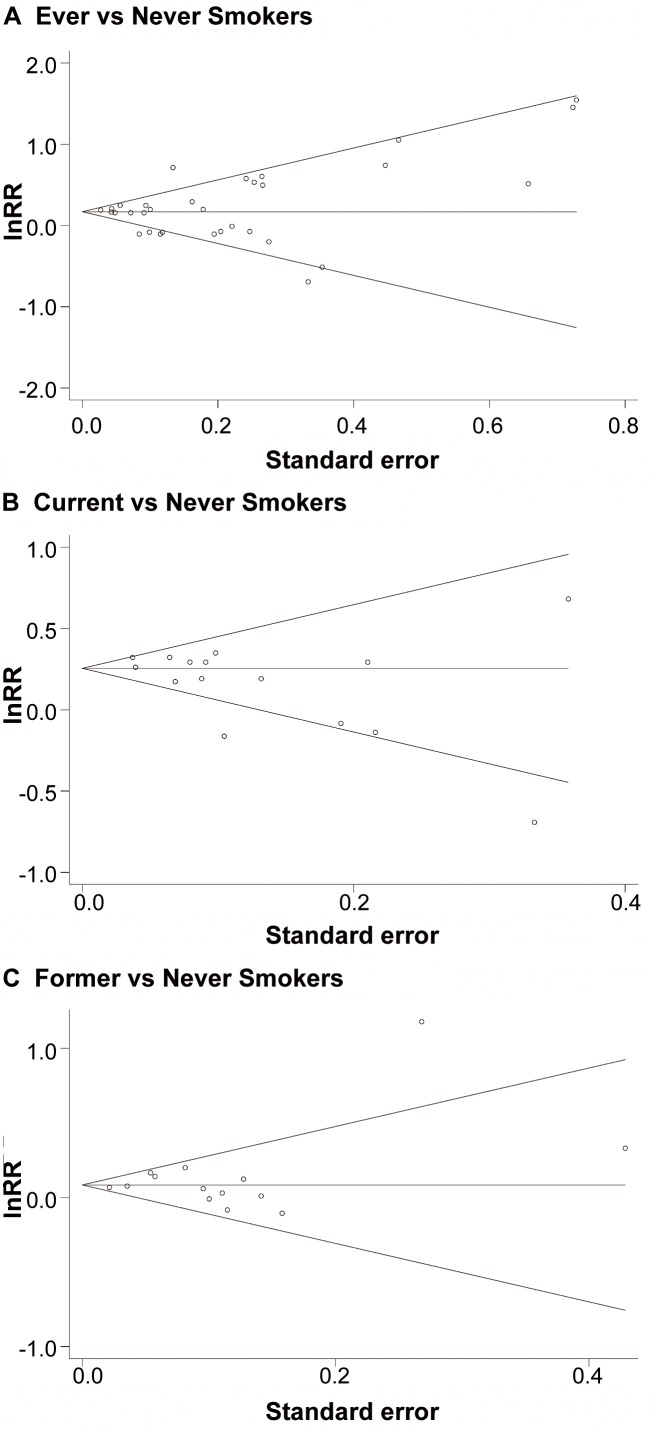
(A–C) Funnel plots showing associations of smoking with VTE.